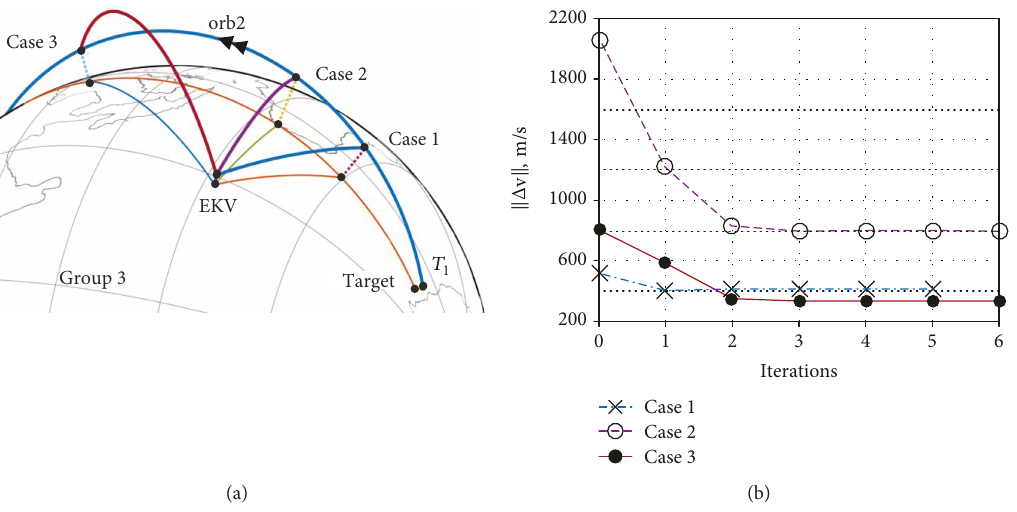
Figure 5: The engagement geometry and the iterative process of Group Table 2: Convergent property of the proposed method.